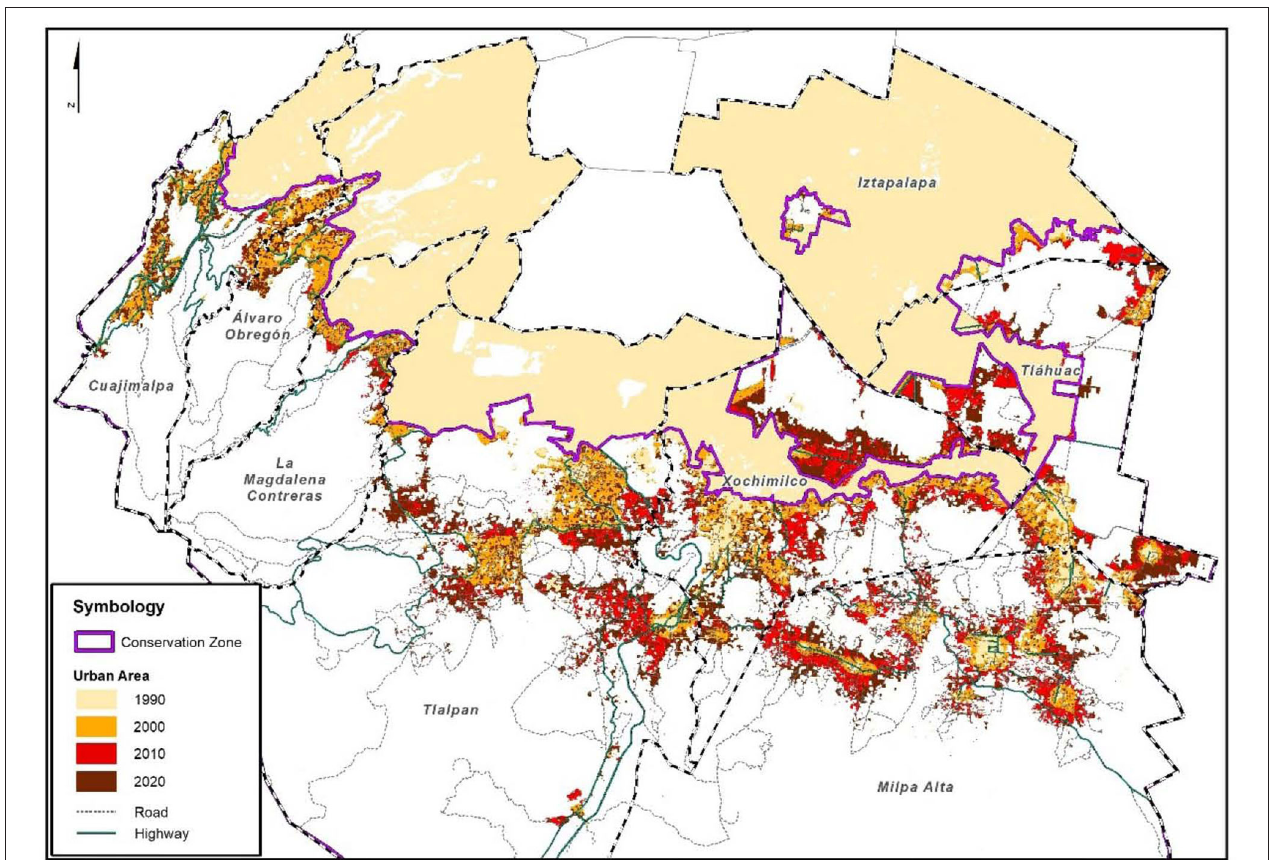
FIGURE 2 | The conservation zone: urban expansion, 1990–2020. Own elaboration from satellite images from sensors Landsat 4 TM; SPOT 4 and 5; Rapid Eye; and information from GDF, 2012 and INEGI,